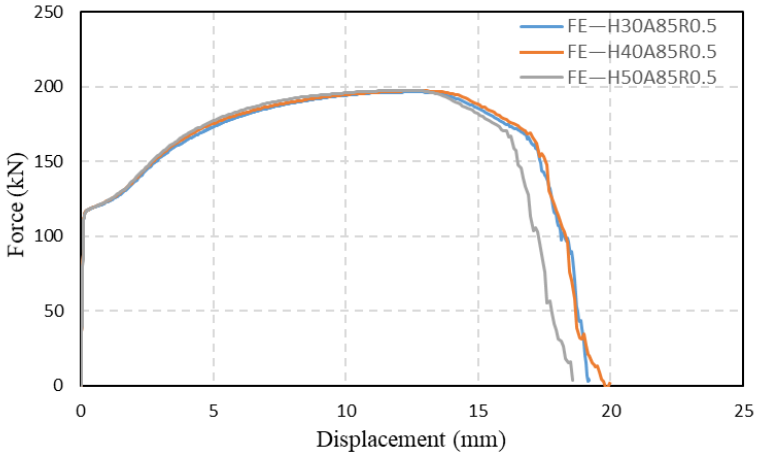
Figure 9. E ff ect of hole ratio on load–displacement Figure 9. Effect of hole ratio on load–displacement curves.